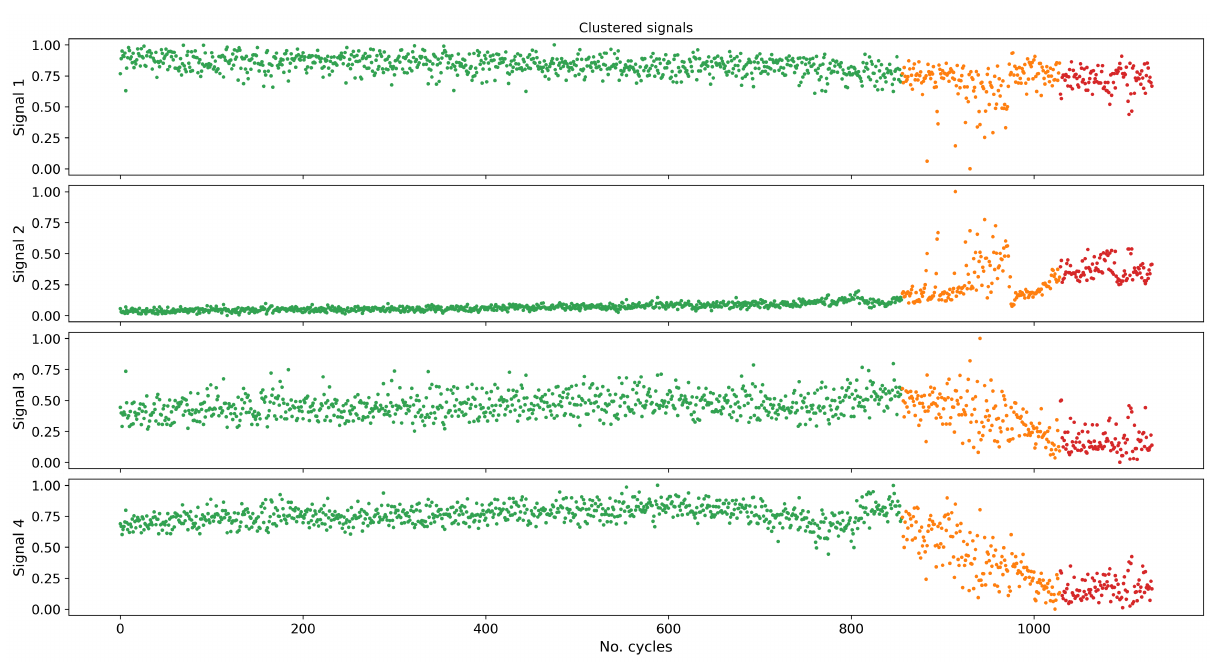
Figure 13. Clustering results of initial signals from Figure